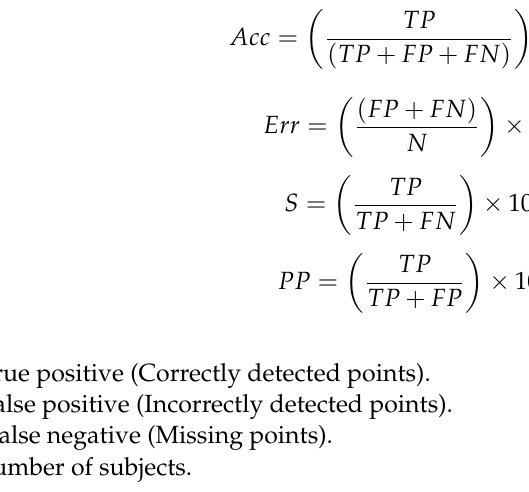
Table 1. Performance evaluation of the CnD algorithm for 219